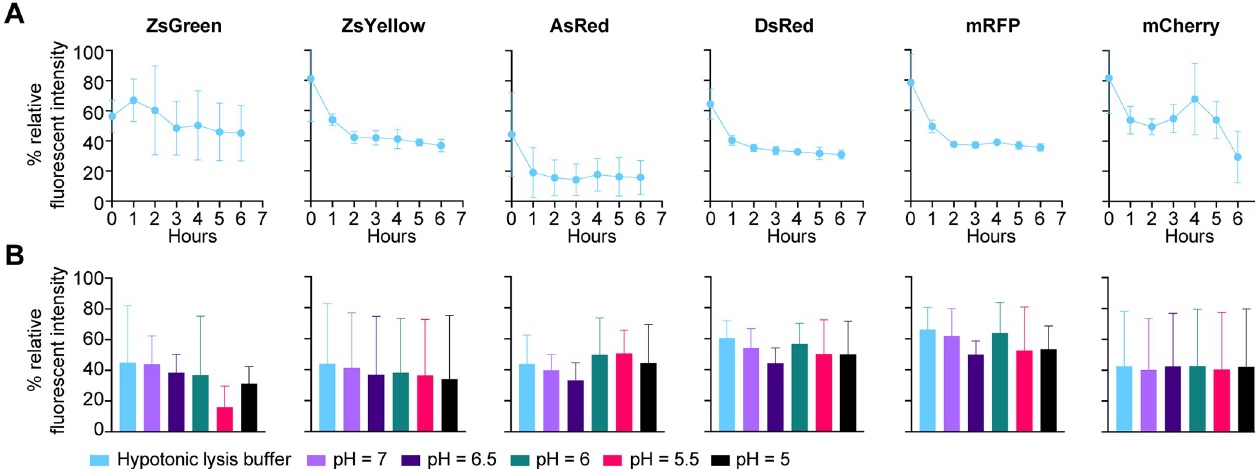
Fig 2. In vitro stability assay shows comparable stabilities of selected fluorophores. Lysates of 1 million respective FP-expressing B16-F10 cells were generated in hypotonic lysis buffer and incubated at A) 37˚C in pH 7.4 or B) 37˚C in pH ranging from 5–7.4. Fluorescence intensity data was collected over time at the indicated time points ( A ) or immediately following pH treatment ( B ). Data was normalized to the maximum fluorescence intensity of each FP for every independent experiment.